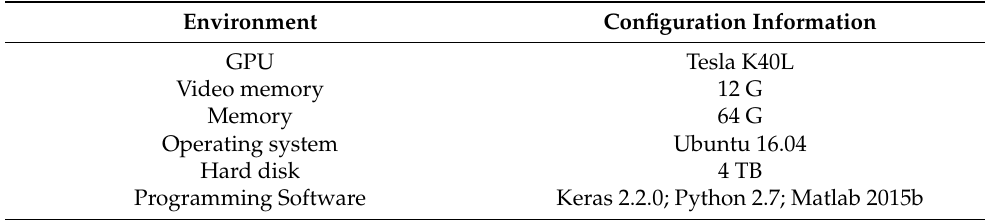
Table 1. Experimental hardware and software configuration. Environment